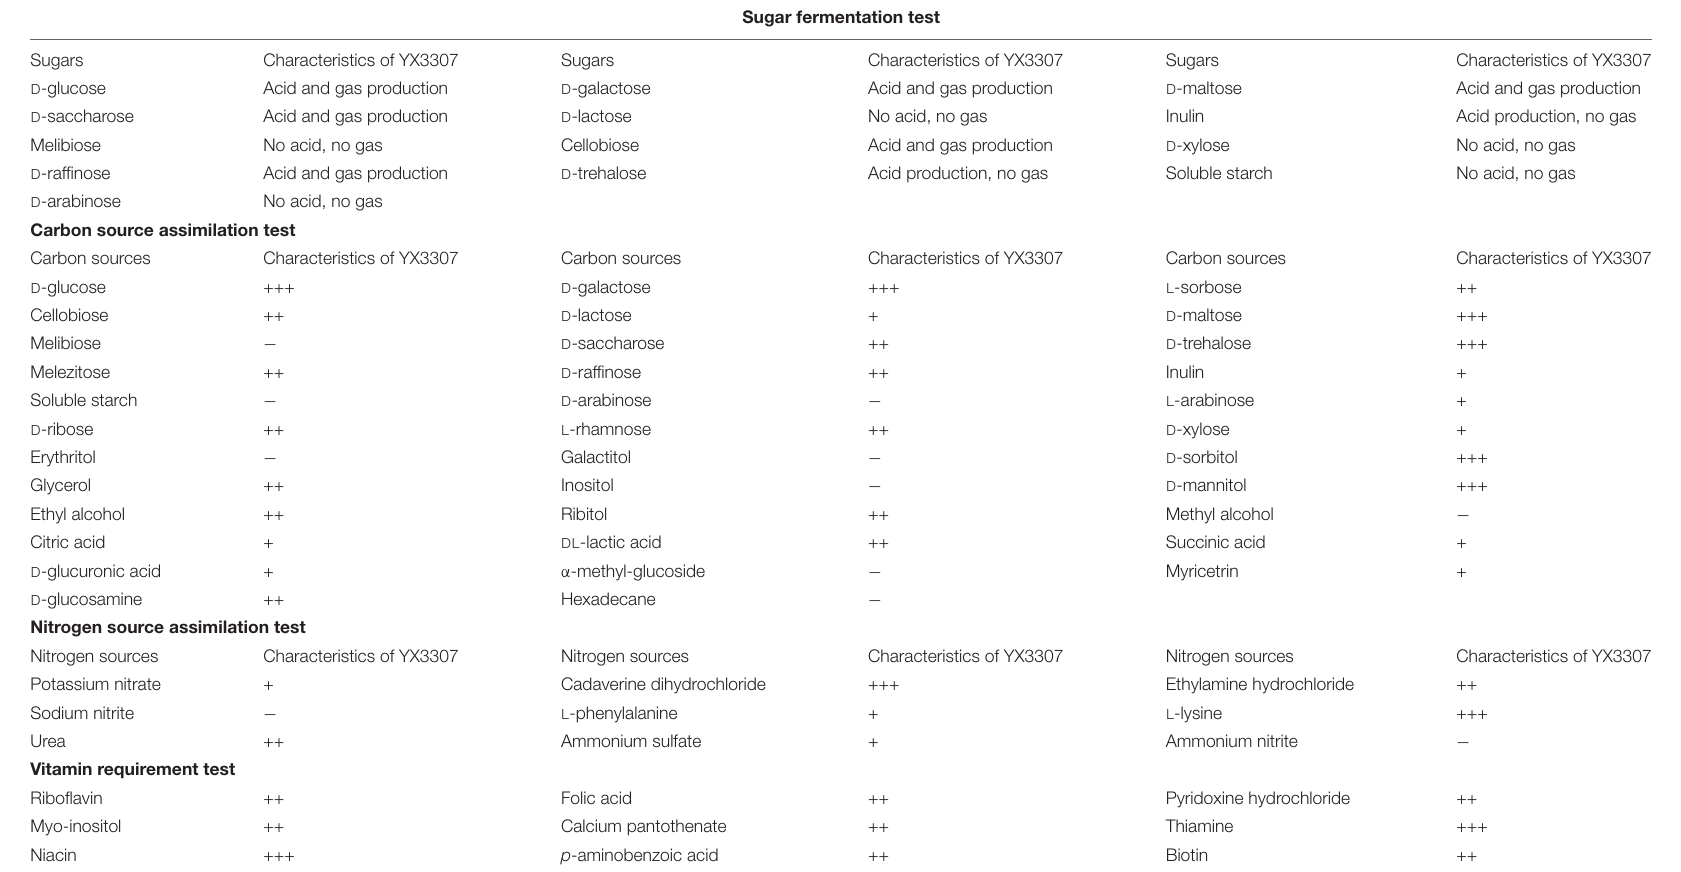
TABLE 1 | Physiological and biochemical characteristics